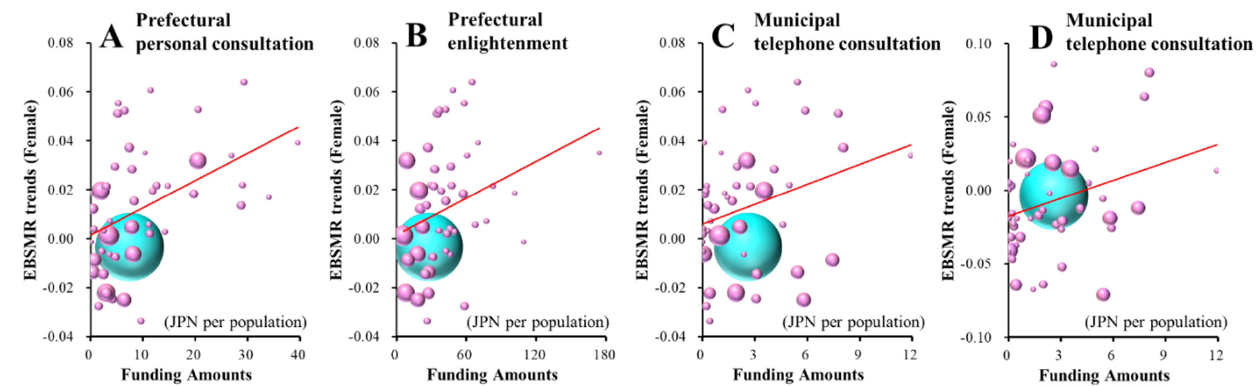
Figure 7. Effects of the amount of funding provided to sub-divisions of EFECBSC on female EBSMR trends of suicide mortalities of school-aged populations ( A – C ) and caused by school-related motives of school-aged populations ( D ) were analysed by forward multiple regression analysis. Ordinates indicate female EBSMR trends of suicide mortality of school- aged populations and school-related motives of school-aged populations between 2009 and 2018, and abscissas indicate the amount of funding provided to EFECBSC sub-divisions (JPY per population). Light blue and red spheres indicate national and female EBSMR trends and population sizes, respectively. Red lines indicate the regression lines of significantly negative (increased suicide mortality) factors. Female EBSMR trends of school-aged populations = 0.0009 × (prefec-